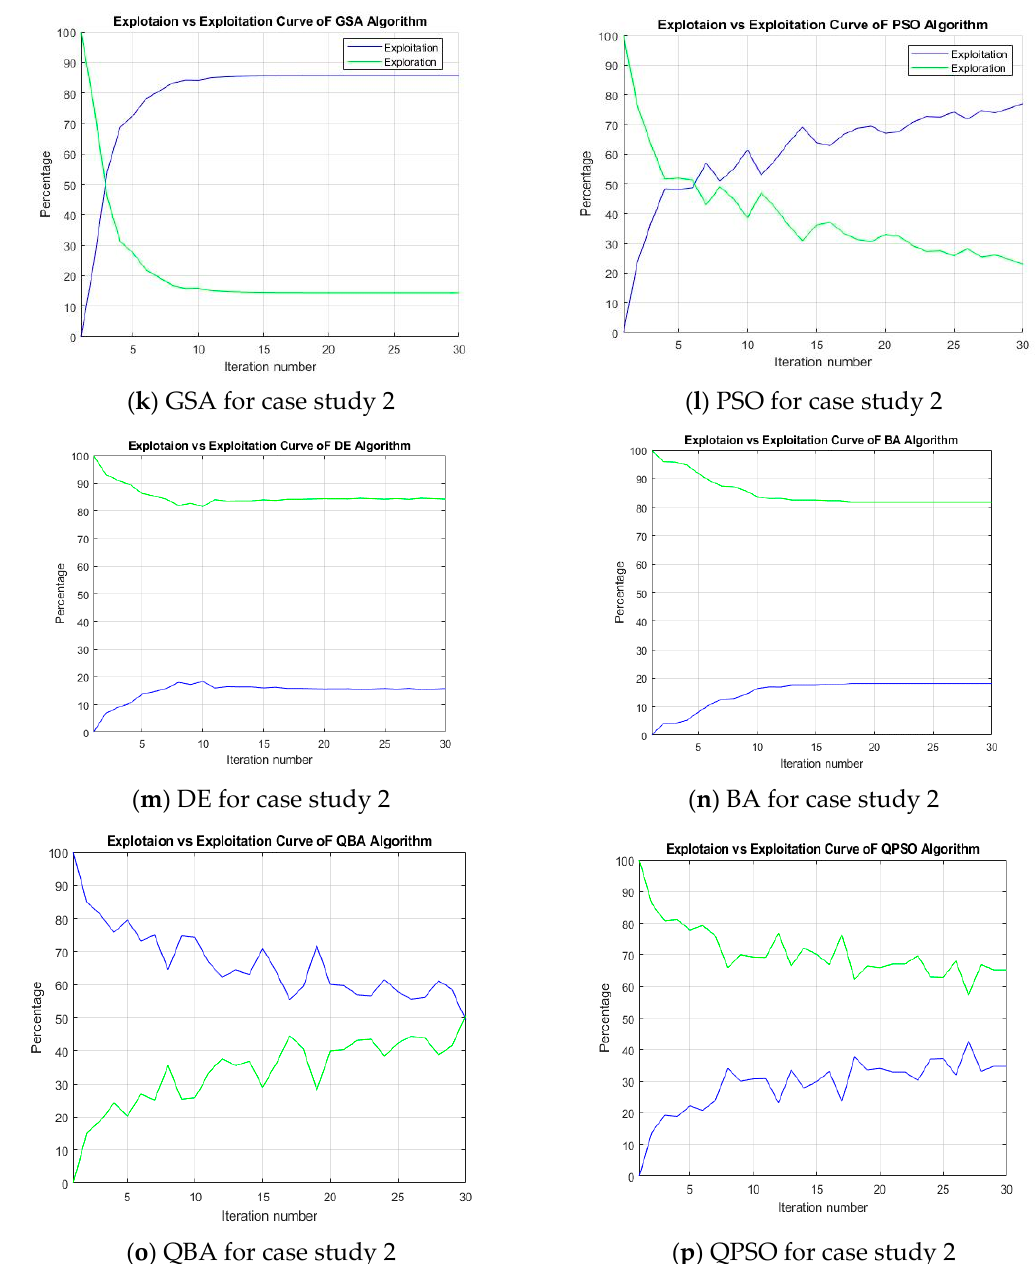
Figure 8. Exploration and exploitation.